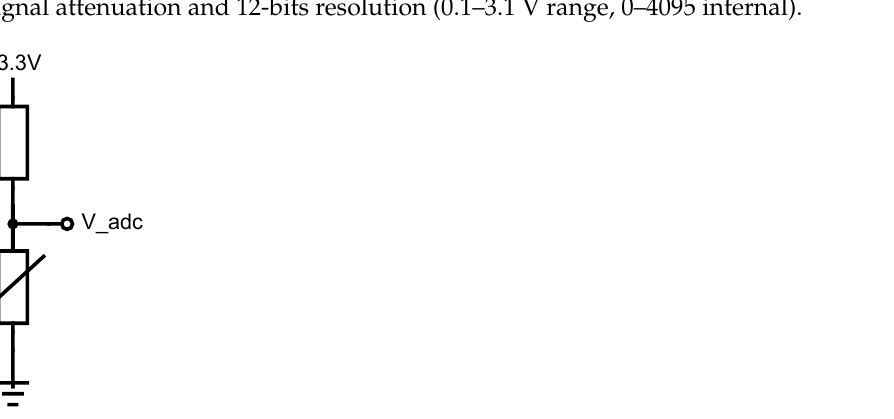
Figure 4. Voltage divider circuit used in measuring the voltage on the flex sensor ( V adc ), represented as a variable